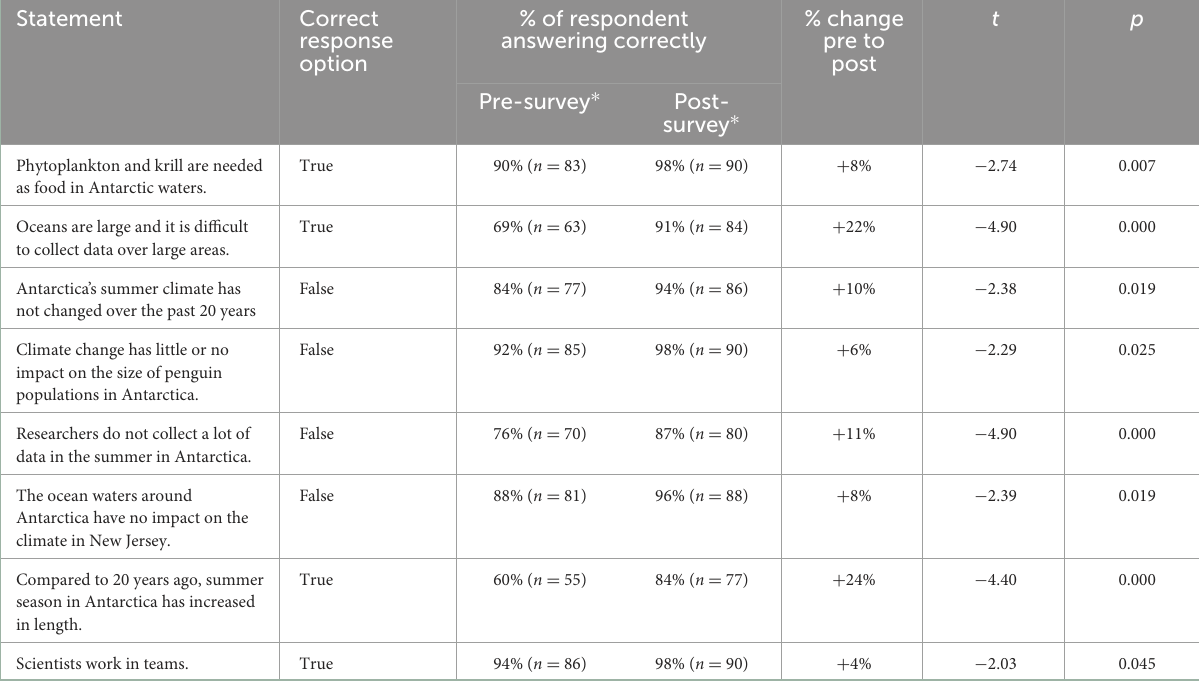
TABLE 2 Rockman et al. report from “ Antarctic Edge: 70 ◦ South ” audience surveys knowledge items with significant pre-post gains ( N = 92). Statement